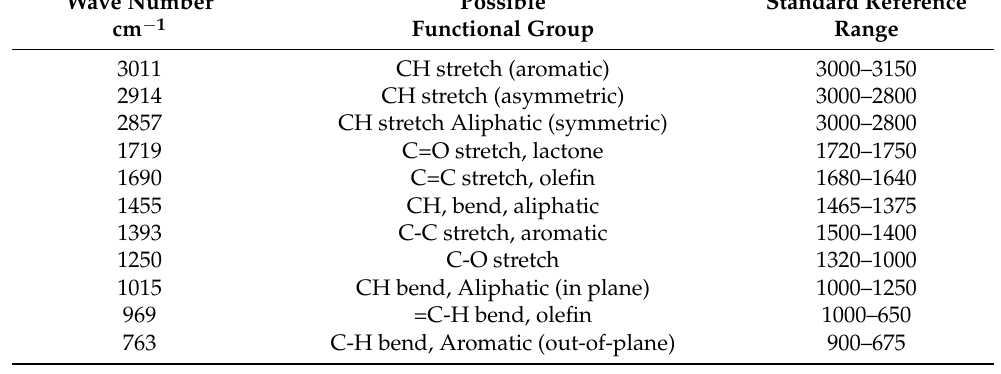
Figure 2. FTIR analysis of isolated compound.